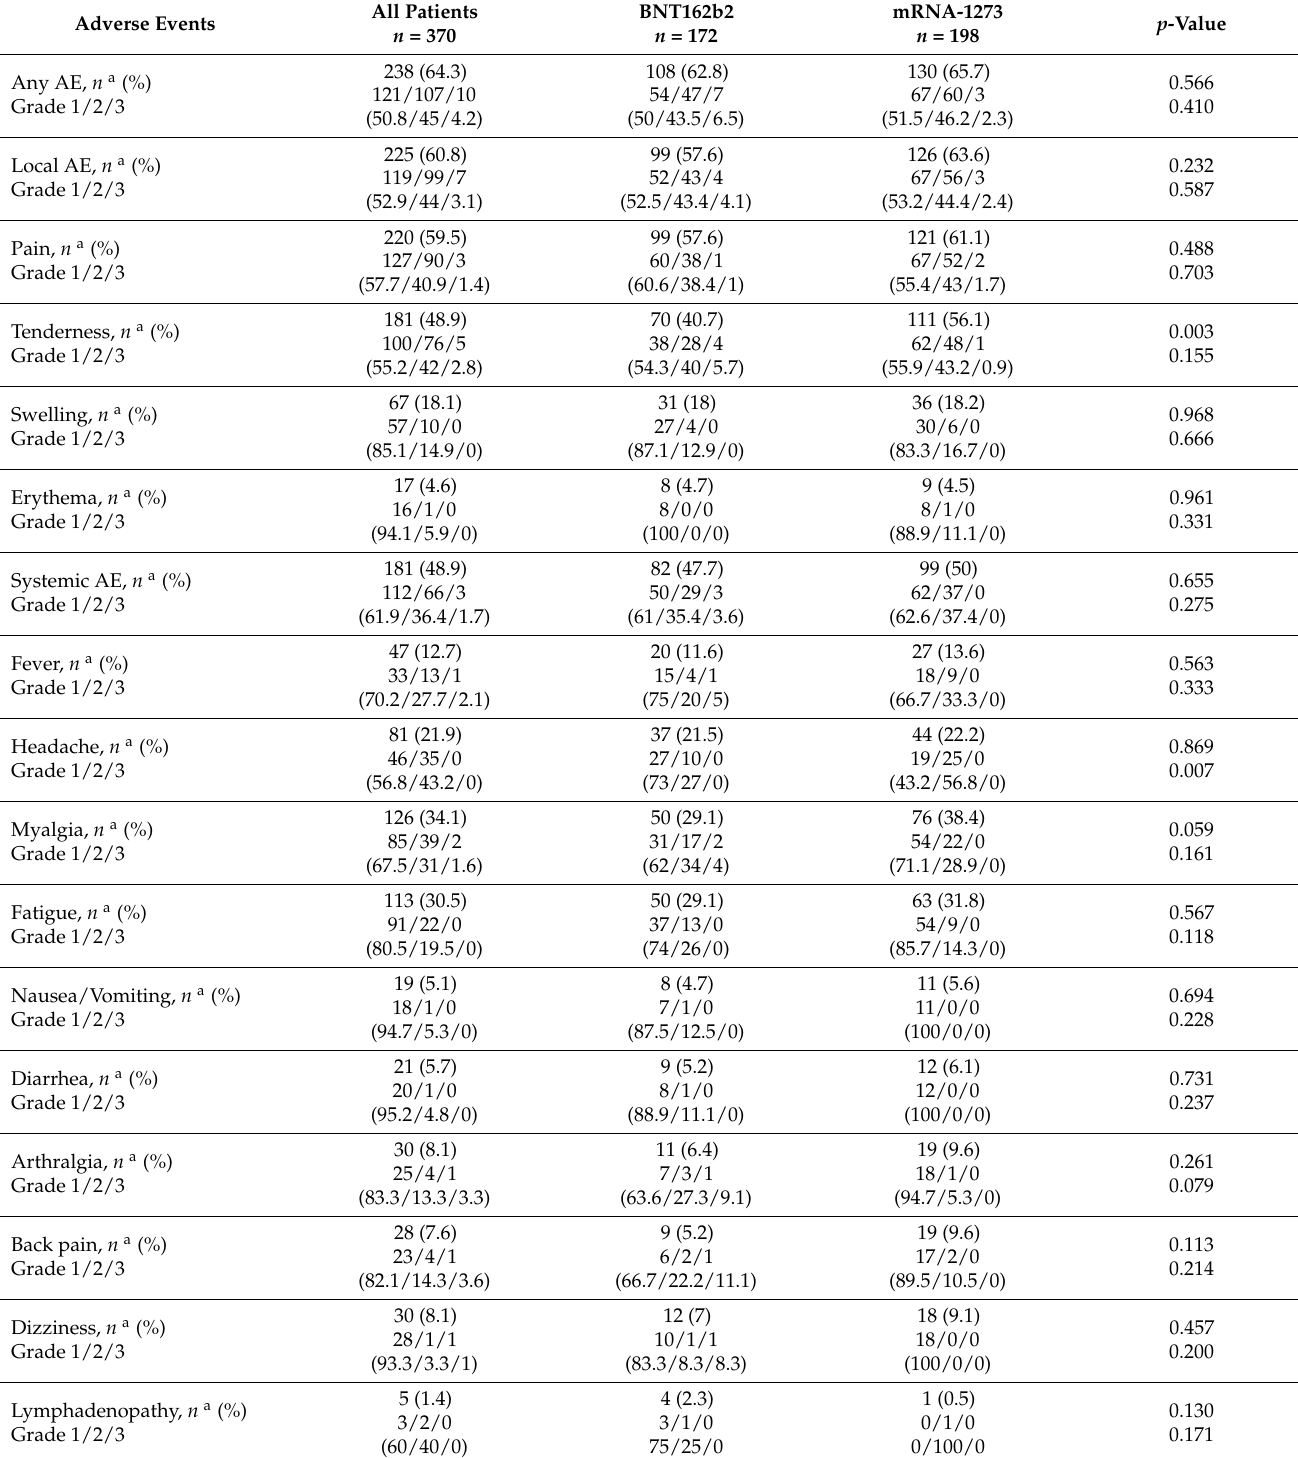
Table 2. Incidence of adverse events following the booster dose with the BNT162b2 as compared to the mRNA-1273